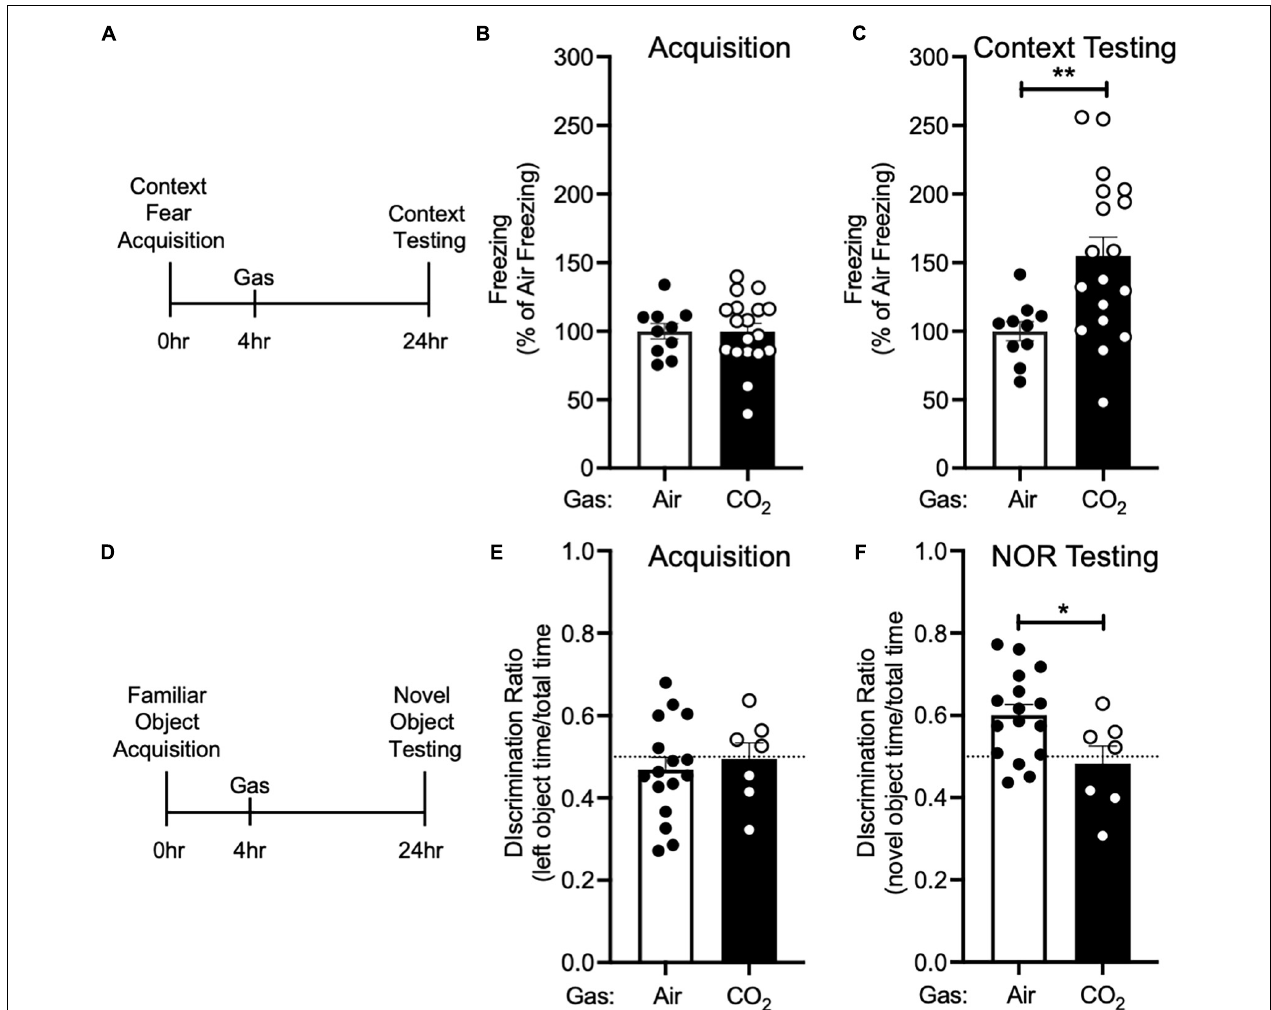
FIGURE 3 | CO 2 Inhalation after acquisition enhances context fear memory, but decreases novel object recognition (A) Experimental timeline. 4 h after context fear acquisition, mice were exposed to air or 10% CO 2 for 30 min. 24 h after acquisition, context fear memory was assessed. (B) Freezing during acquisition prior to gas exposure did not differ between air and 10% CO 2 -treated groups [ t (26) = 0.01532, p = 0.9879, n = 10, 18]. (C) Exposure to 10% CO 2 4 h after acquisition increased freezing during the context fear test [ t (23.95) = 3.531, ** p = 0.0017]. (D) Experimental timeline. 4 h after novel object acquisition, mice were exposed to air or